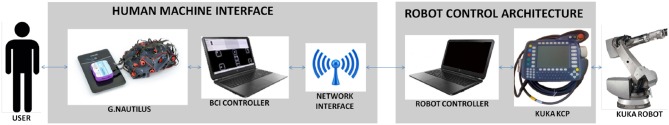
The High level description of the system and of its constituents.